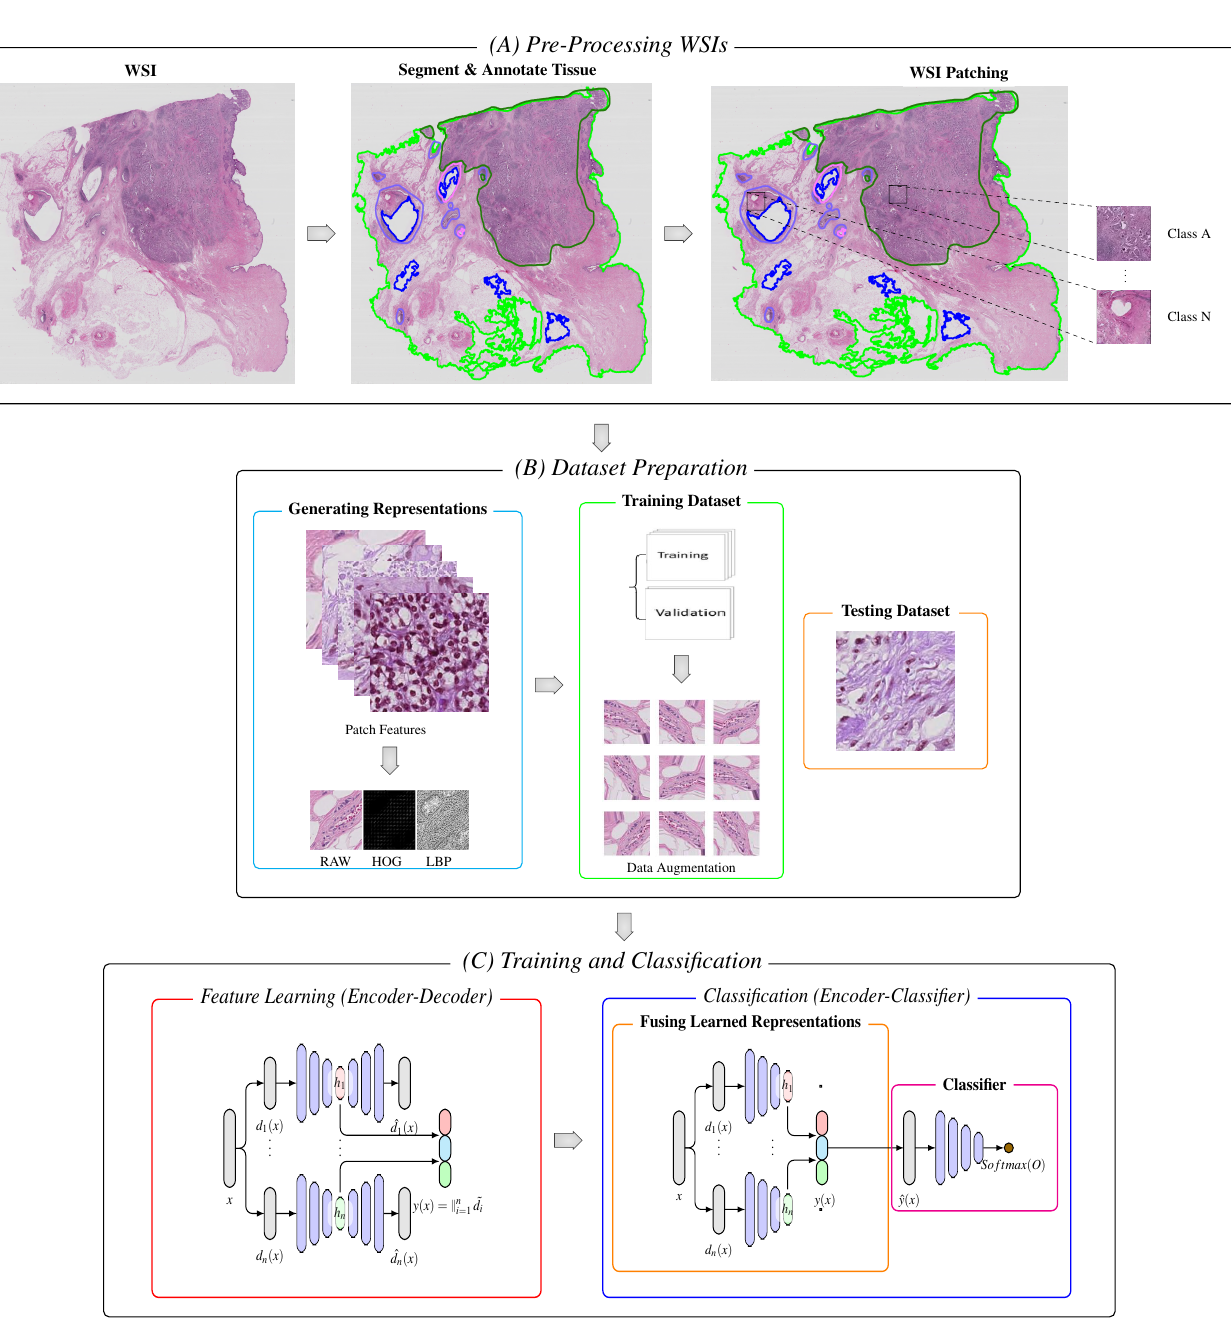
Figure 1. Block diagram of the proposed model. (A) Following segmentation and annotation, image patches are extracted from the tissue regions of the WSIs. (B) Patches are encoded into a set of descriptive feature representations (i.e. RAW, HOG, and LBP). The representations are further split into two portions, and data augmentation is applied to the set of descriptive representations of the training portion. (C-Left) For unsupervised learning, the set of generated descriptive features are feed to the stacked autoencoders without labels which embeds the input vectors into a lower-dimensional space. (C-Right) The learned representations are fused together and passed with labels to the classifier with respective labels, which are used to make the final diagnostic prediction and classification.